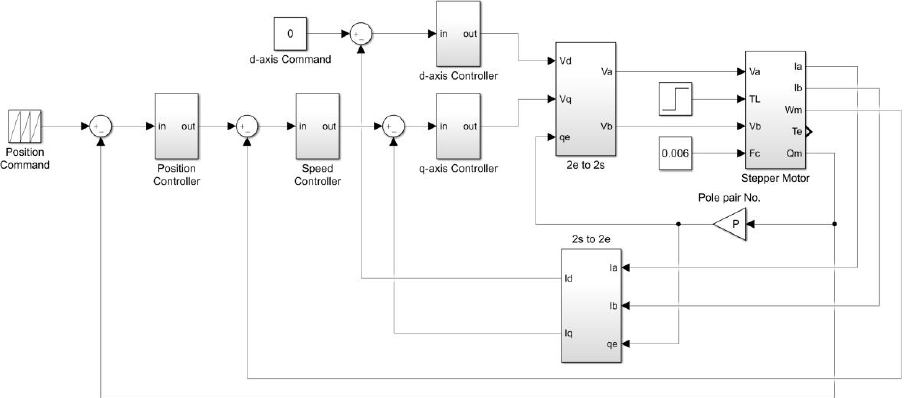
Figure 3. The block diagram for the drive system. Machines 2018 , 6 , x FOR PEER REVIEW